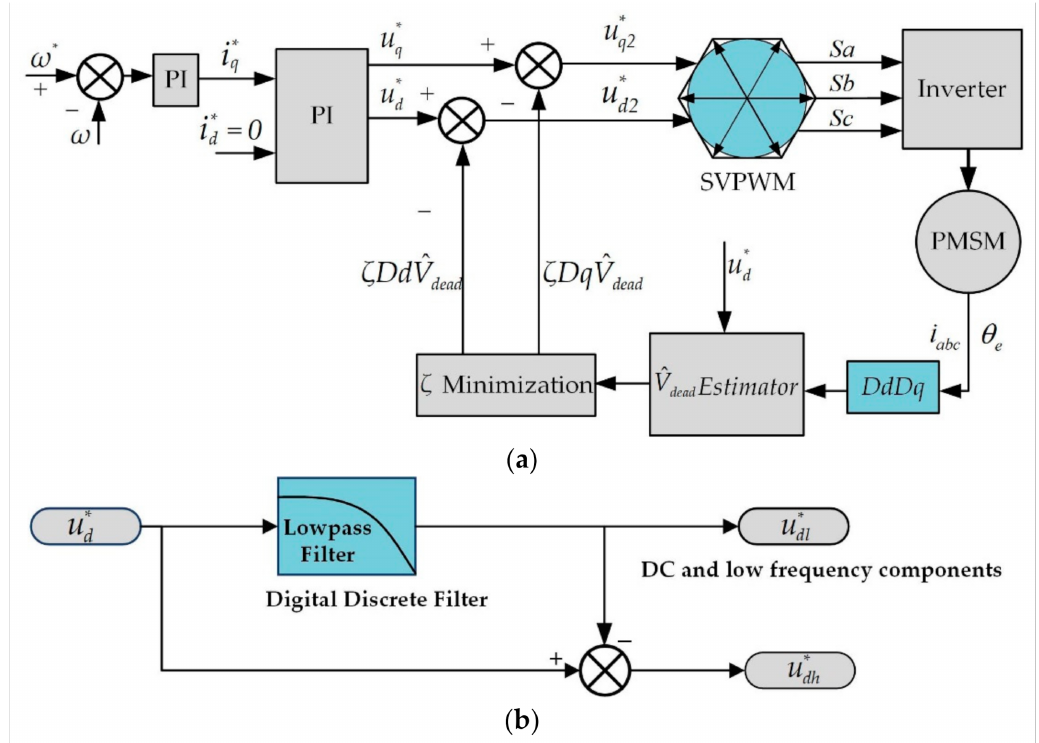
Figure 2. Voltage-source inverter (VSI) nonlinearity compensation with conventional DM-CZD. ( a ) Diagram of VSI nonlinearity compensation under FOC. ( b ) Diagram of extraction of d -axis high-frequency